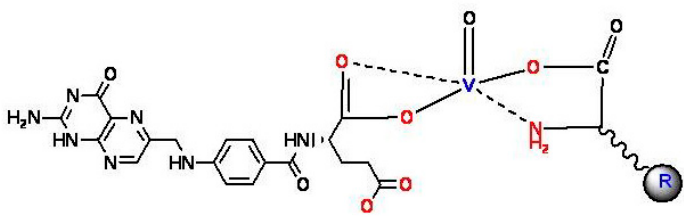
Figure 3. Suggested structures of vanadyl(IV) complexes (R = complementary of amino acids). Table 2. IR frequencies (cm -1 ) of NH 4 [(VO)(FA)(AA n )] complexes.